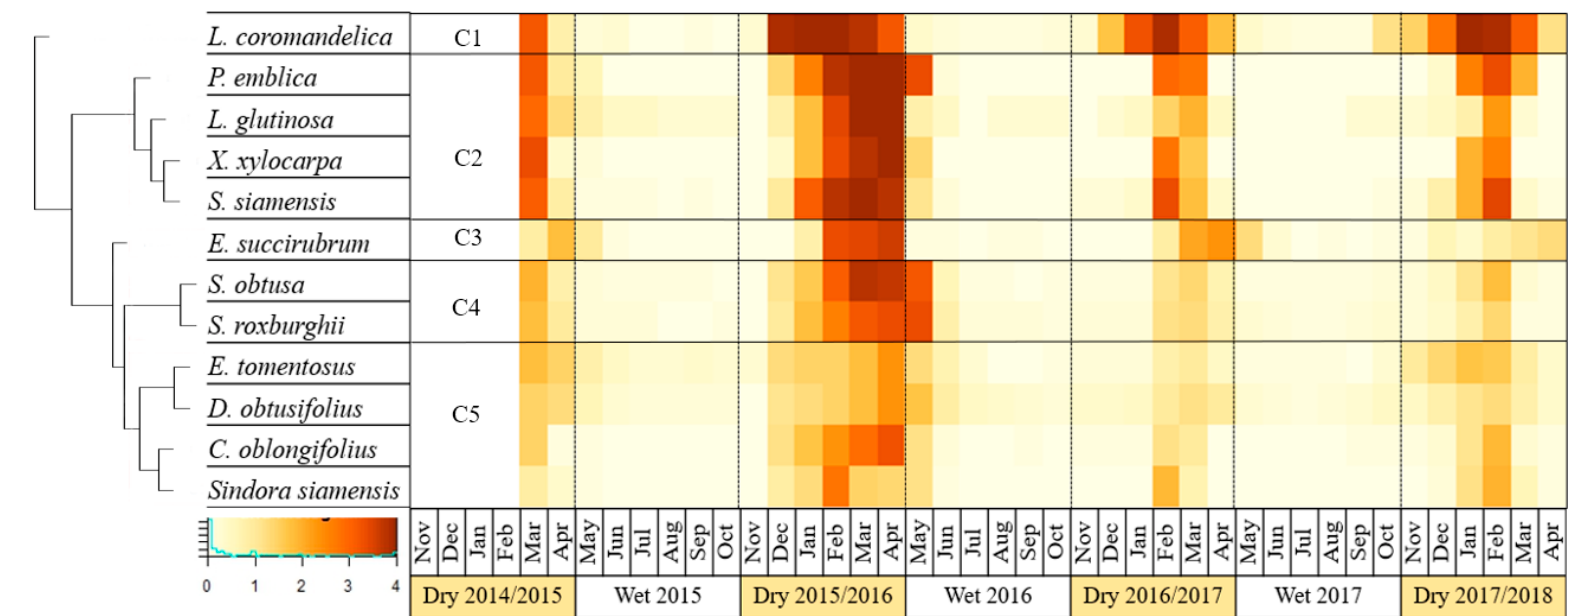
Figure 4. Phenological pattern of leafless stage or bare branch of 12 species clustered into five groups (C1–C5) between March 2015–April 2018 (the black lines mark the separation between the different clusters of species based on their phenological patterns), dark brown indicates leafless condition while pale yellow indicates branch with leaves.